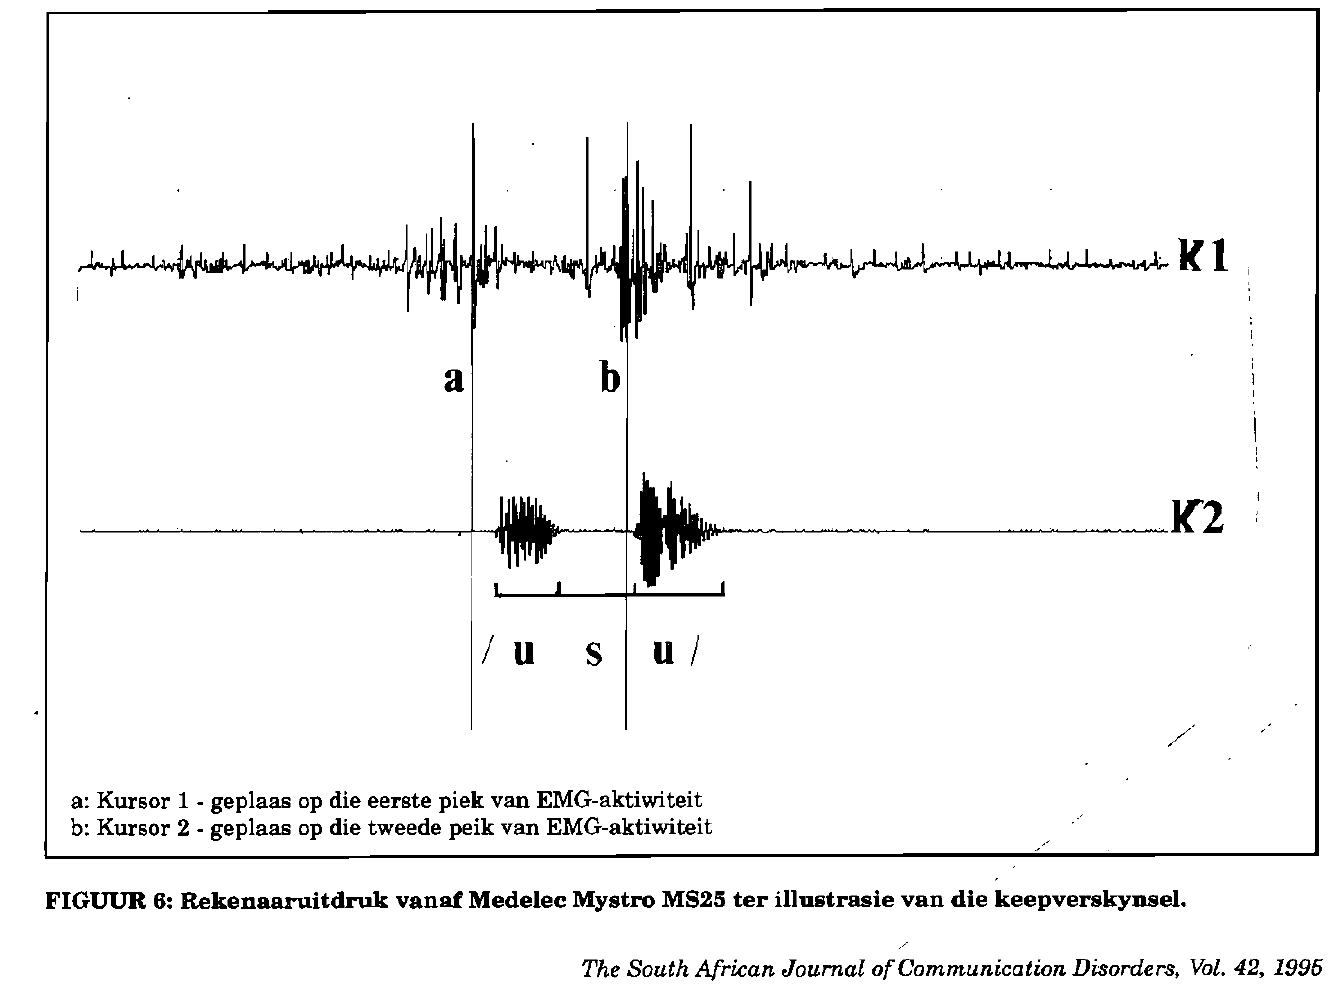
FIGUUR 6: Rekenaaruitdruk vanaf Medelec Mystro MS25 ter illustrasie van die